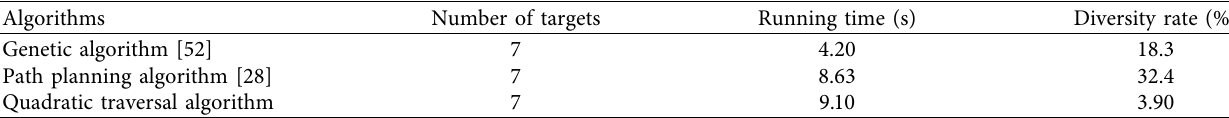
Table 4: Comparison of performance parameters using different